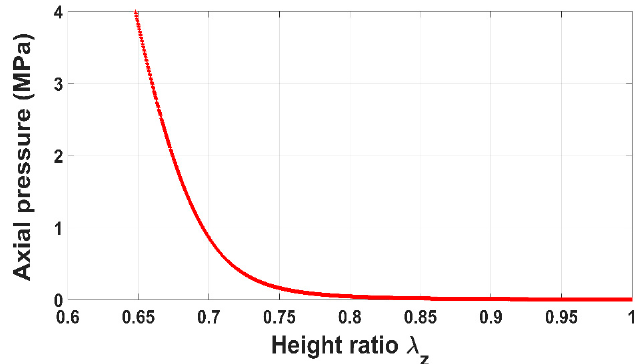
Figure 4. Axial pressure vs. height ratio.